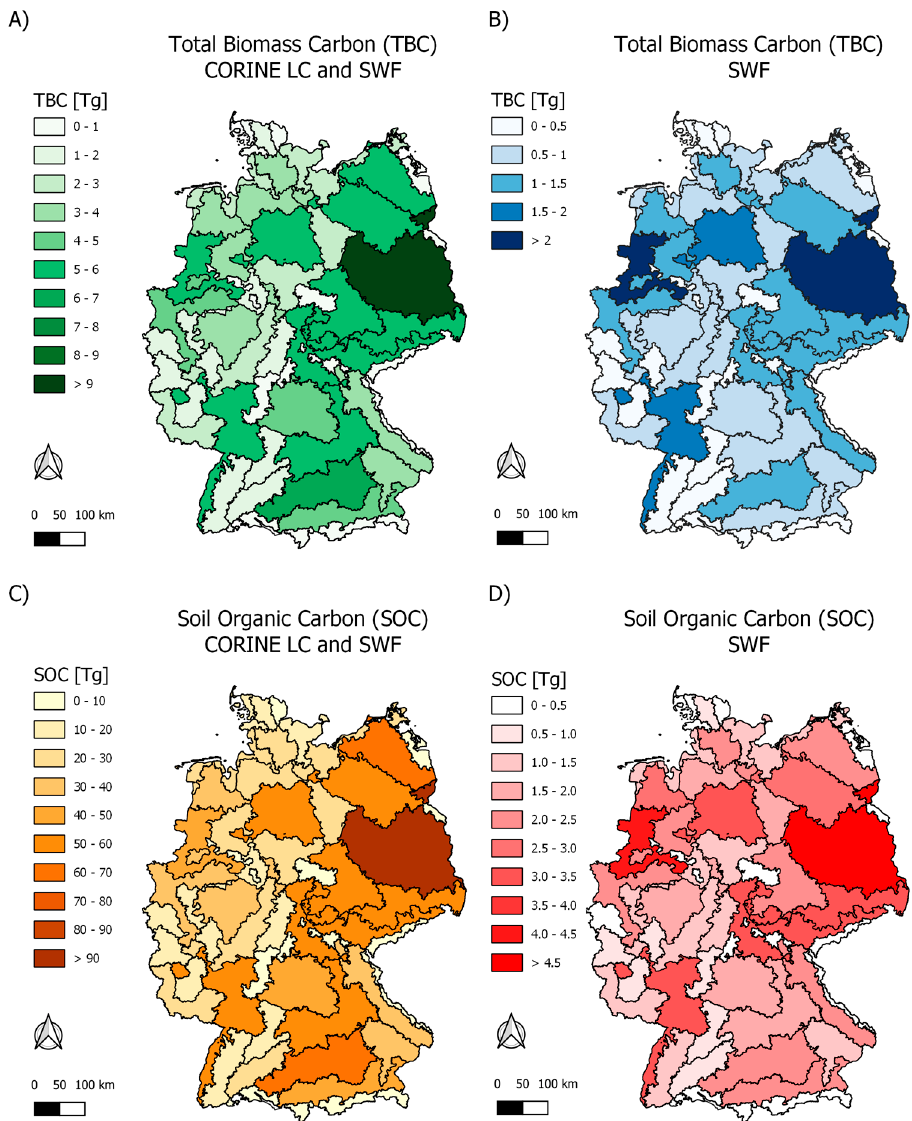
Figure 4. The estimated TBC stock for agricultural land use with SWFs ( A ) and SWF only ( B ); the estimated SOC stock for agricultural land use with SWFs ( C ) and SWF only ( D ). Data sources: Copernicus Land Monitoring Service—High Resolution Layer Small Woody Features—2015 reference year, 2021.